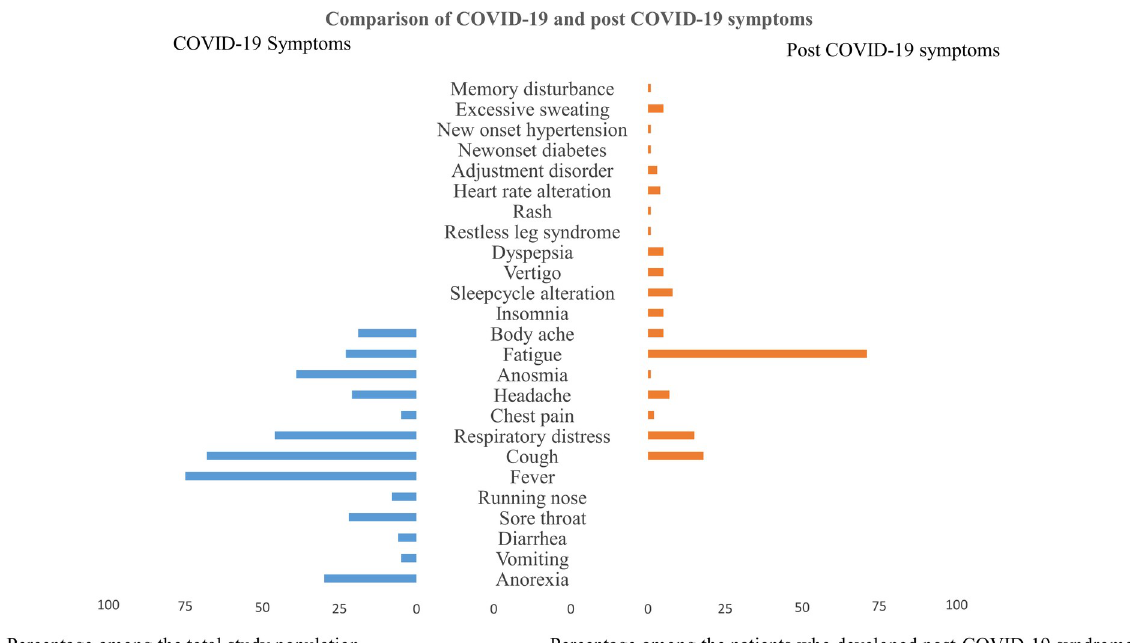
Fig 2. Comparison of COVID-19 and post-COVID-19